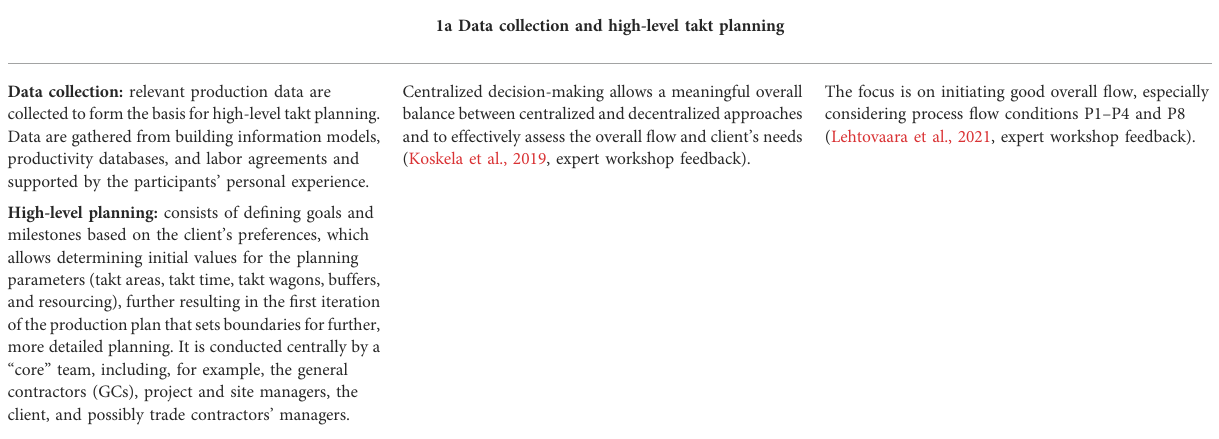
TABLE 2 Decentralized takt production